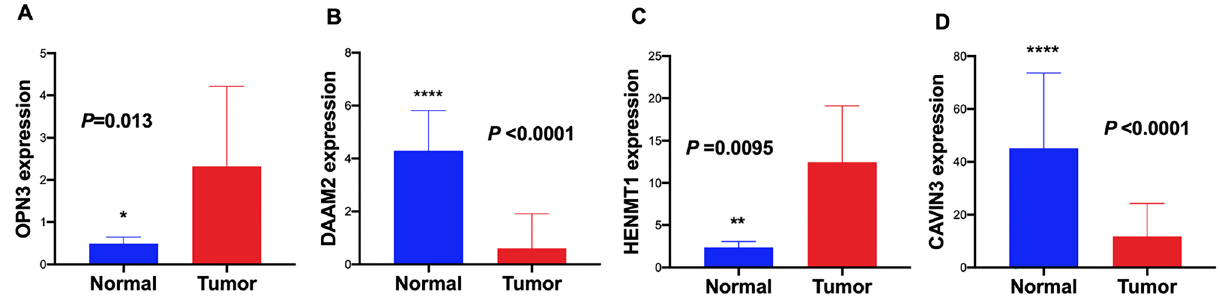
Figure 6. Comparison of the transcript levels of the 4 key mRNAs between CESC and normal tissues. The transcript levels of ( A ) OPN3 and ( C ) HENMT1 were significantly increased but the transcript levels of ( B ) DAAM2 and ( D ) CAVIN3 were significantly decreased in CESC tissues compared with normal tissues. * P < 0.05; ** P < 0.01; *** P < 0.001; **** P < 0.0001